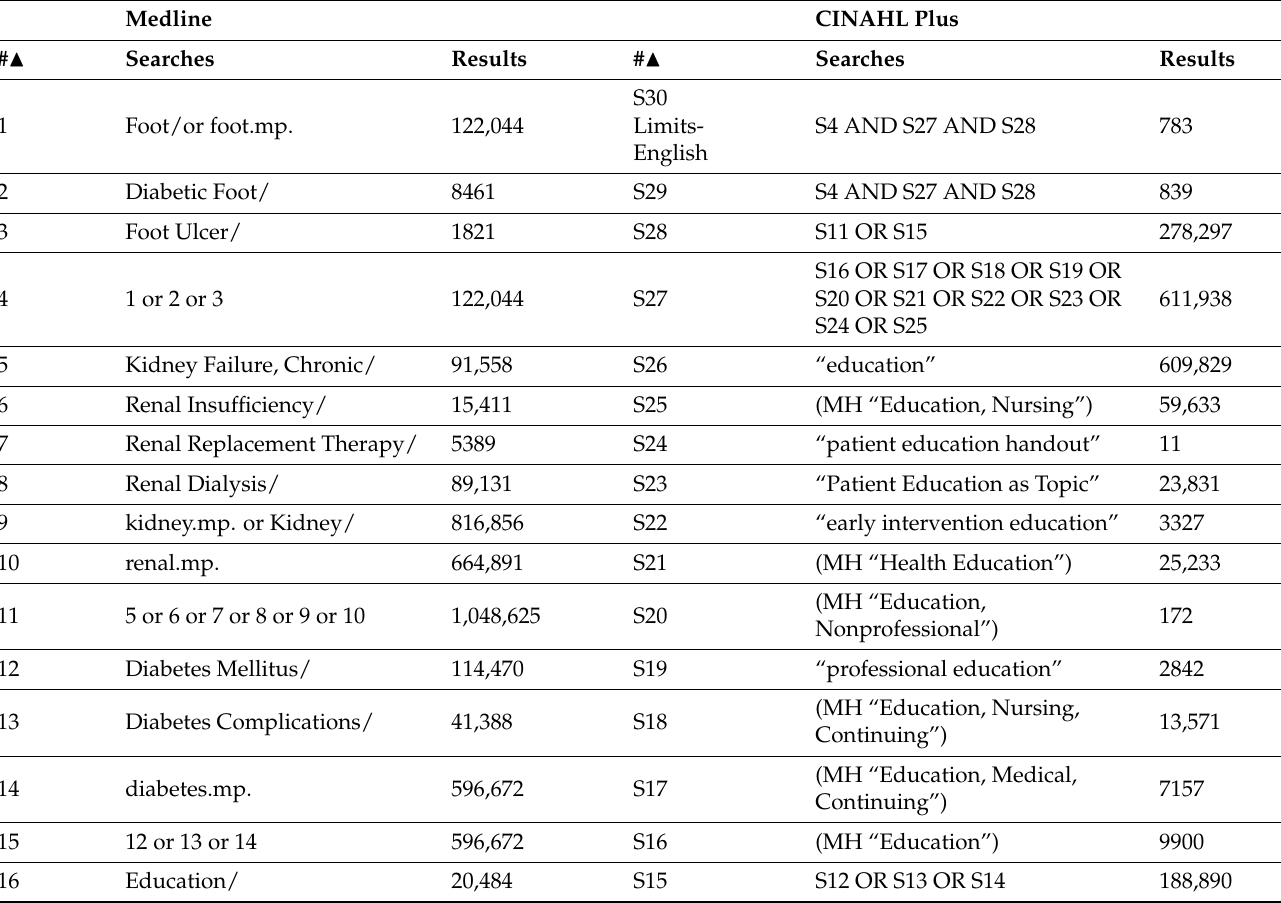
Table A1. Databases (date of access: 15 November